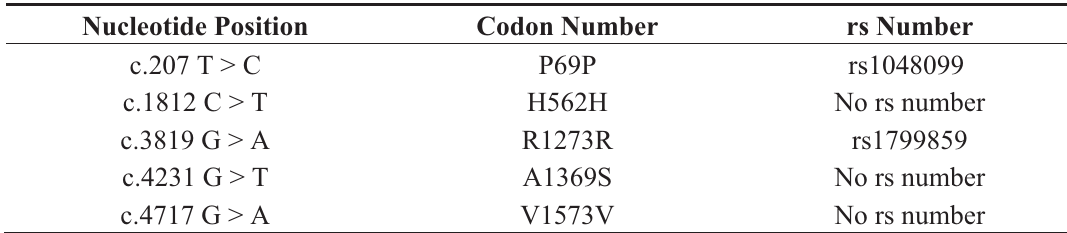
Table 2. Coding variants for ABCC8 gene (the presence of an rs number represents a change that has been reported in the literature previously).